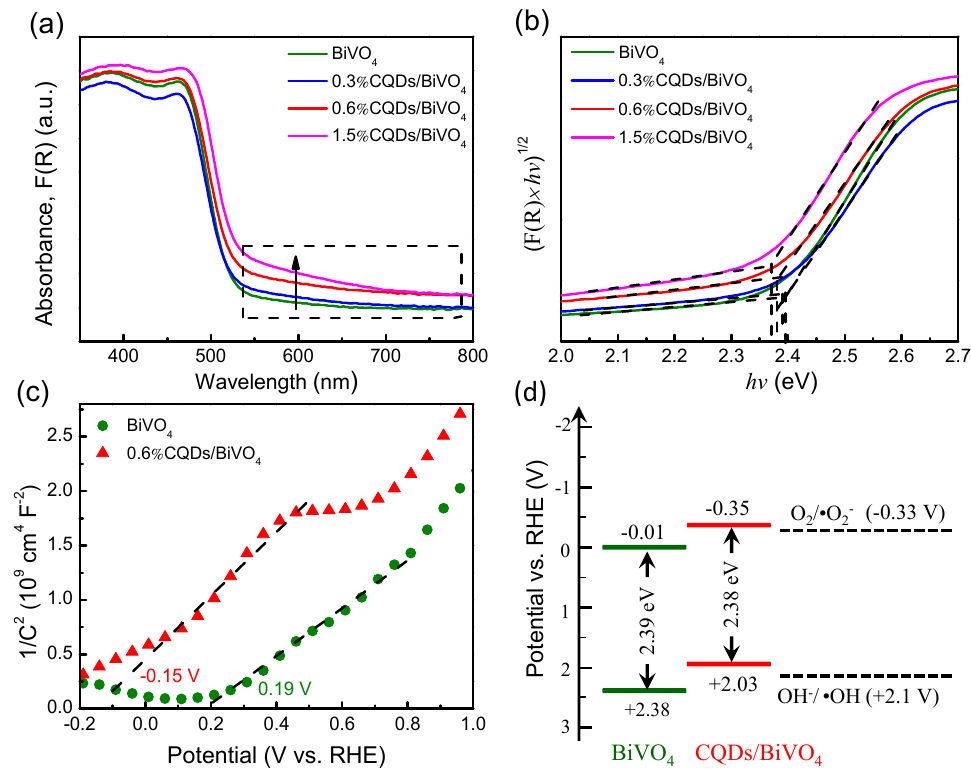
Figure 4. ( a ) UV–vis absorption spectra and ( b ) the corresponding Tauc plots of the as-synthesized BiVO 4 and CQDs/BiVO 4 composites with different CQDs amounts. ( c ) The Mott–Schottky plots and ( d ) estimated band structures of BiVO 4 and 0.6%CQDs/BiVO 4 .